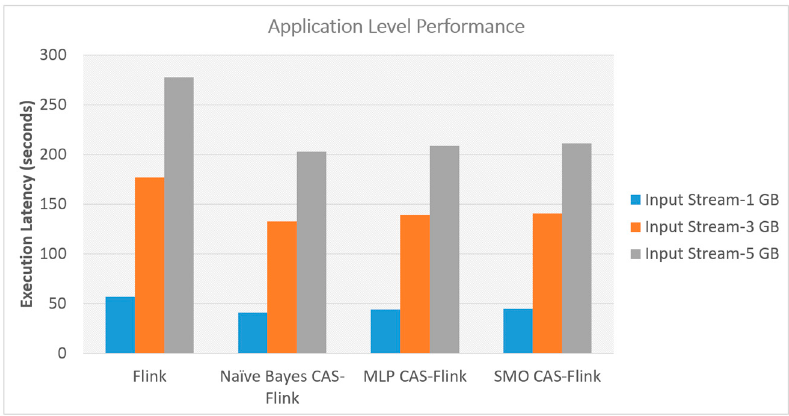
Figure 16. Application level performance evaluation of the system based on different workload analysis modules.